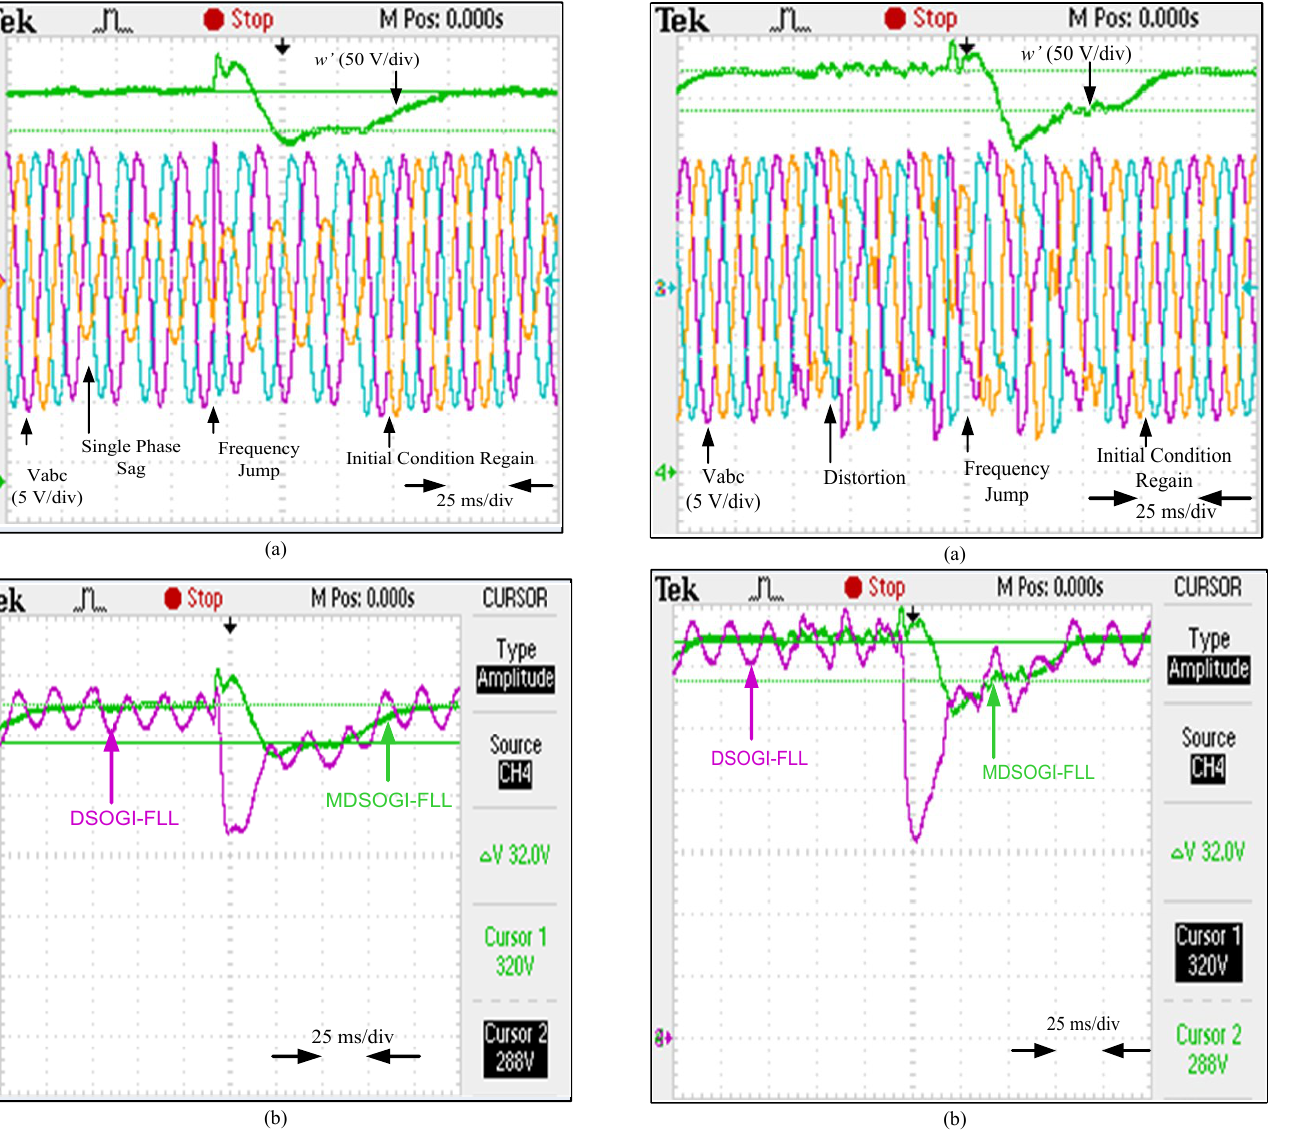
Fig. 11. Experimental results with dc offset and harmonics in supply voltage: (a) Three-phase supply voltage (b) Estimated frequency with DSOGI-FLL and